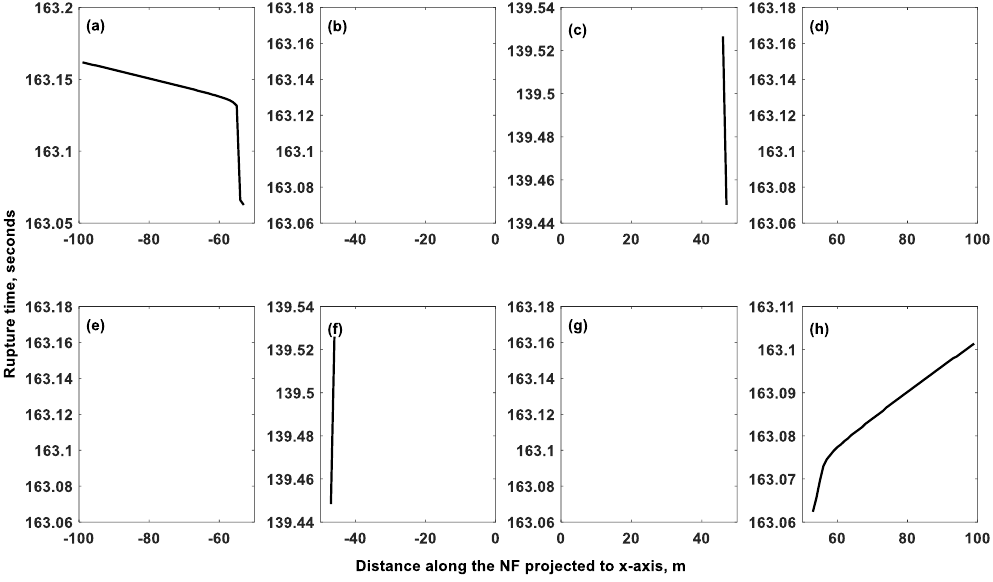
Figure 6—Rupture along the NFs in Model C (i.e., cohesion = 0.7